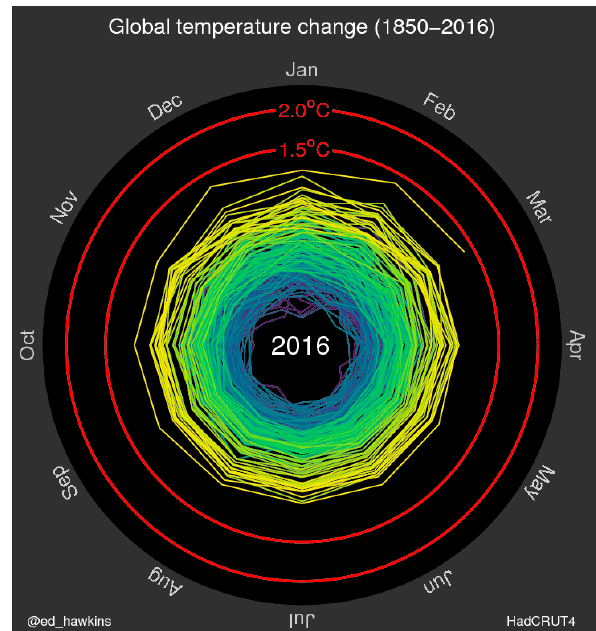
Figure 2. Ed Hawkins’ original climate spiral gif. An animated version of the gif can be viewed at http://www.climate-lab-book.ac.uk/2016/spiralling-global-temperatures/. Licensed by Ed Hawkins